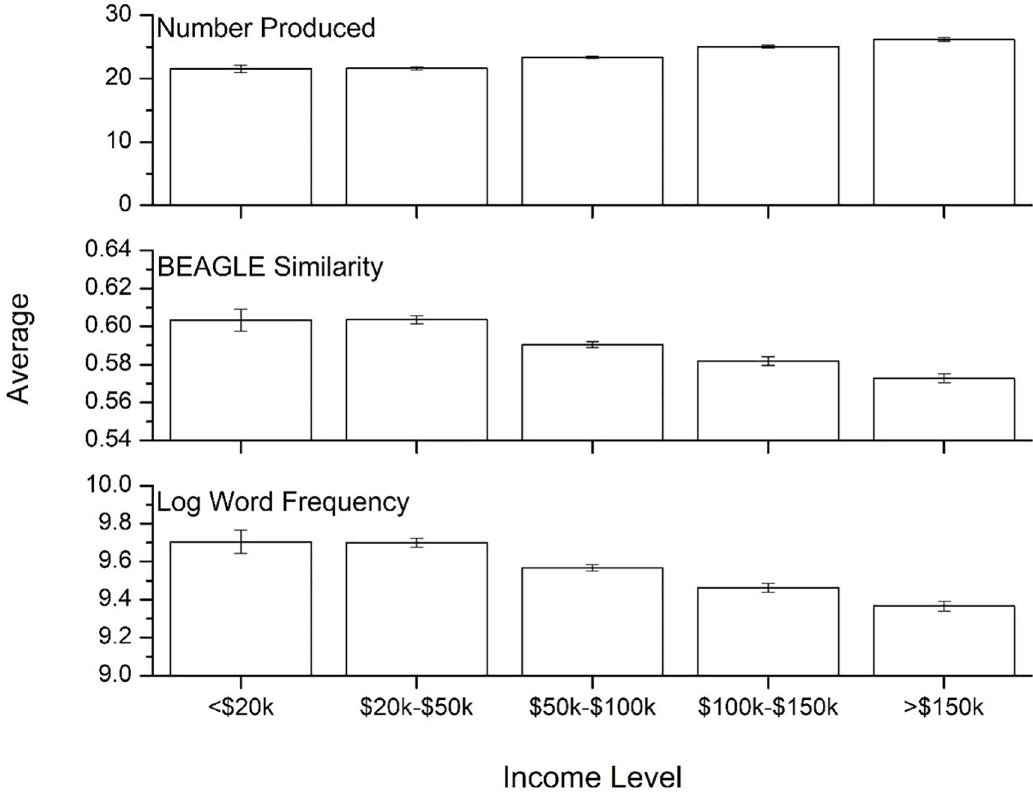
Fig 6. Means for the three psycholinguistic variables by income level. Error bars represent 95% confidence intervals.